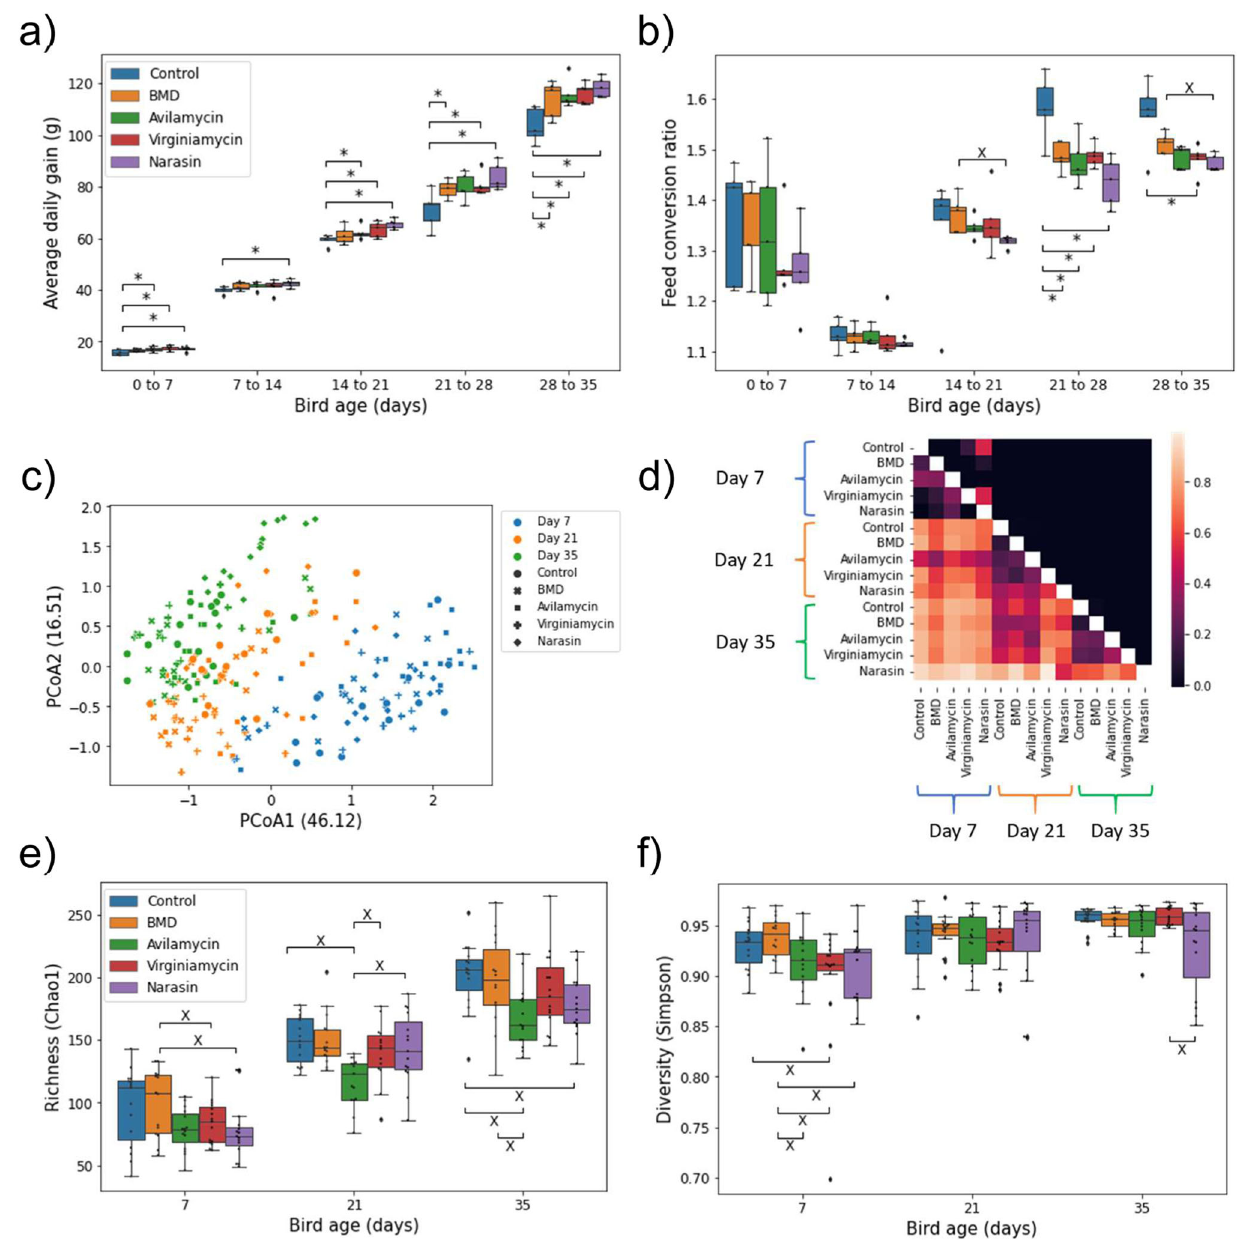
Fig. 1 Effects of four different AGP on bird performance and cecal microbiome composition. a ) Box plot showing the average daily gain as a function of bird age. ADG was calculated separately for each week of the experiment for each of the treatment groups. b ) Like a, but for the feed conversion ratio as a function of bird age. n = 5 pens per treatment in a and b. c ) Principal coordinates analysis using the Bray-Curtis dissimilarity among 16 S microbiome pro fi les. Each symbol represents a sample. The numbers in parenthesis indicate the percentage of the dissimilarity variance explained by each of the fi rst two principal components. d ) ANOSIM analysis for samples from birds of different ages and AGP treatment groups. In the heatmap, values below the diagonal represent the ANOSIM R-score. Lower values indicate more similar microbial communities. Values above the diagonal indicate the corresponding p-value for the null hypothesis of similar communities. e ) Amplicon sequence variant (ASV) richness for cecal samples from birds of different ages and AGP treatment groups quanti fi ed with the Chao1 index. f ) Like e but for ASV diversity quanti fi ed using the Simpson index. n = 15 birds per treatment in e and f. The boxes in a, b, e and f represent the median and interquartile range; whiskers indicate the range of the distribution excluding outliers. Outliers are at least 1.5 times the interquartile range below or above the fi rst and third quartile, respectively. *: One-sided Mann-Whitney U p-value < 0.05; X: Two- sided p-value <